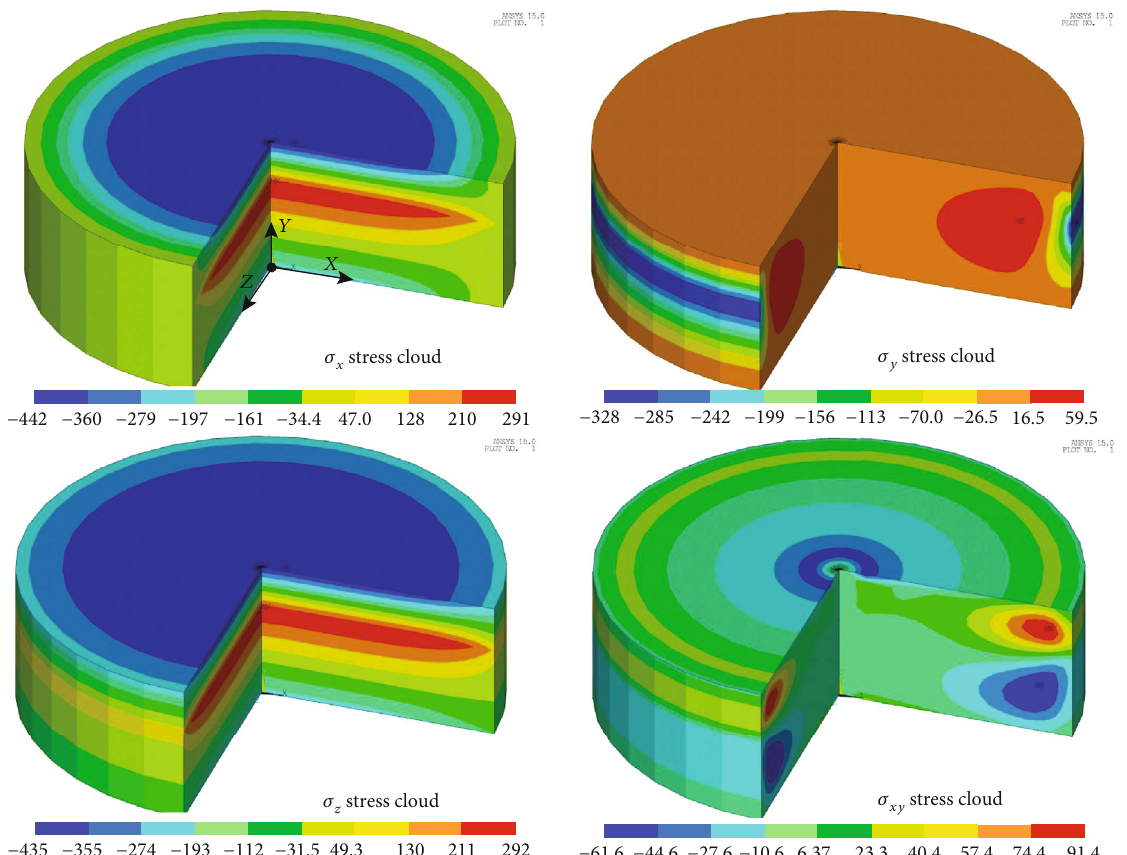
Figure 18: Stress cloud diagrams under capillary water absorption (unit: